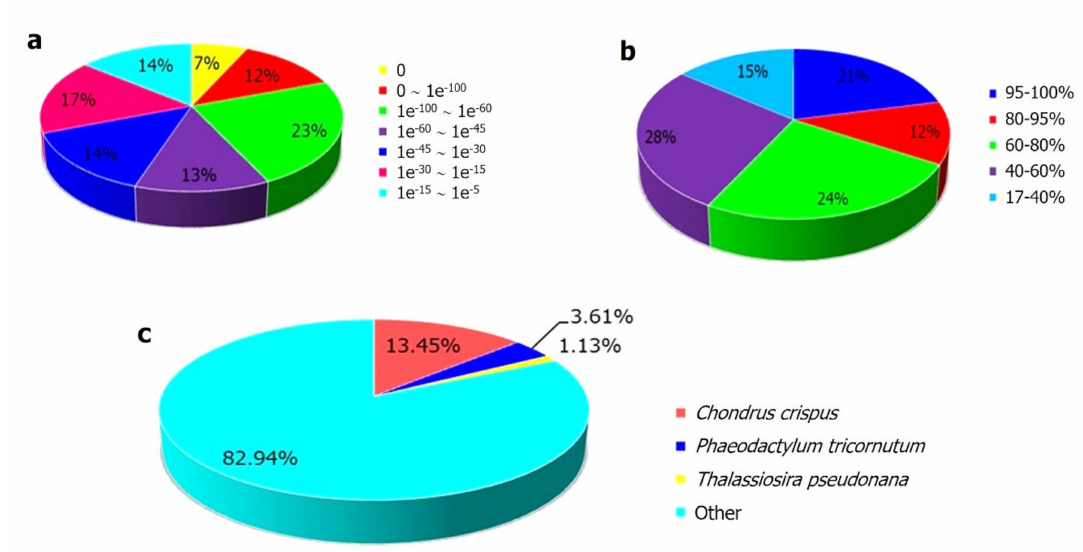
Figure 1. Functional annotation of the Kappaphycus alvarezii transcriptome. Characteristics of the similarity search of the assembled sequences against the Uniprot databases. ( a ) E -value distribution of BLAST hits for each unique sequence with E -value ≤ 10 − 5 . ( b ) Similarity distribution of the top BLAST hits for each sequence. ( c ) Species distribution of total homologous sequences with E -value ≤ 10 − 5 . The first hit of each sequence was used for statistical